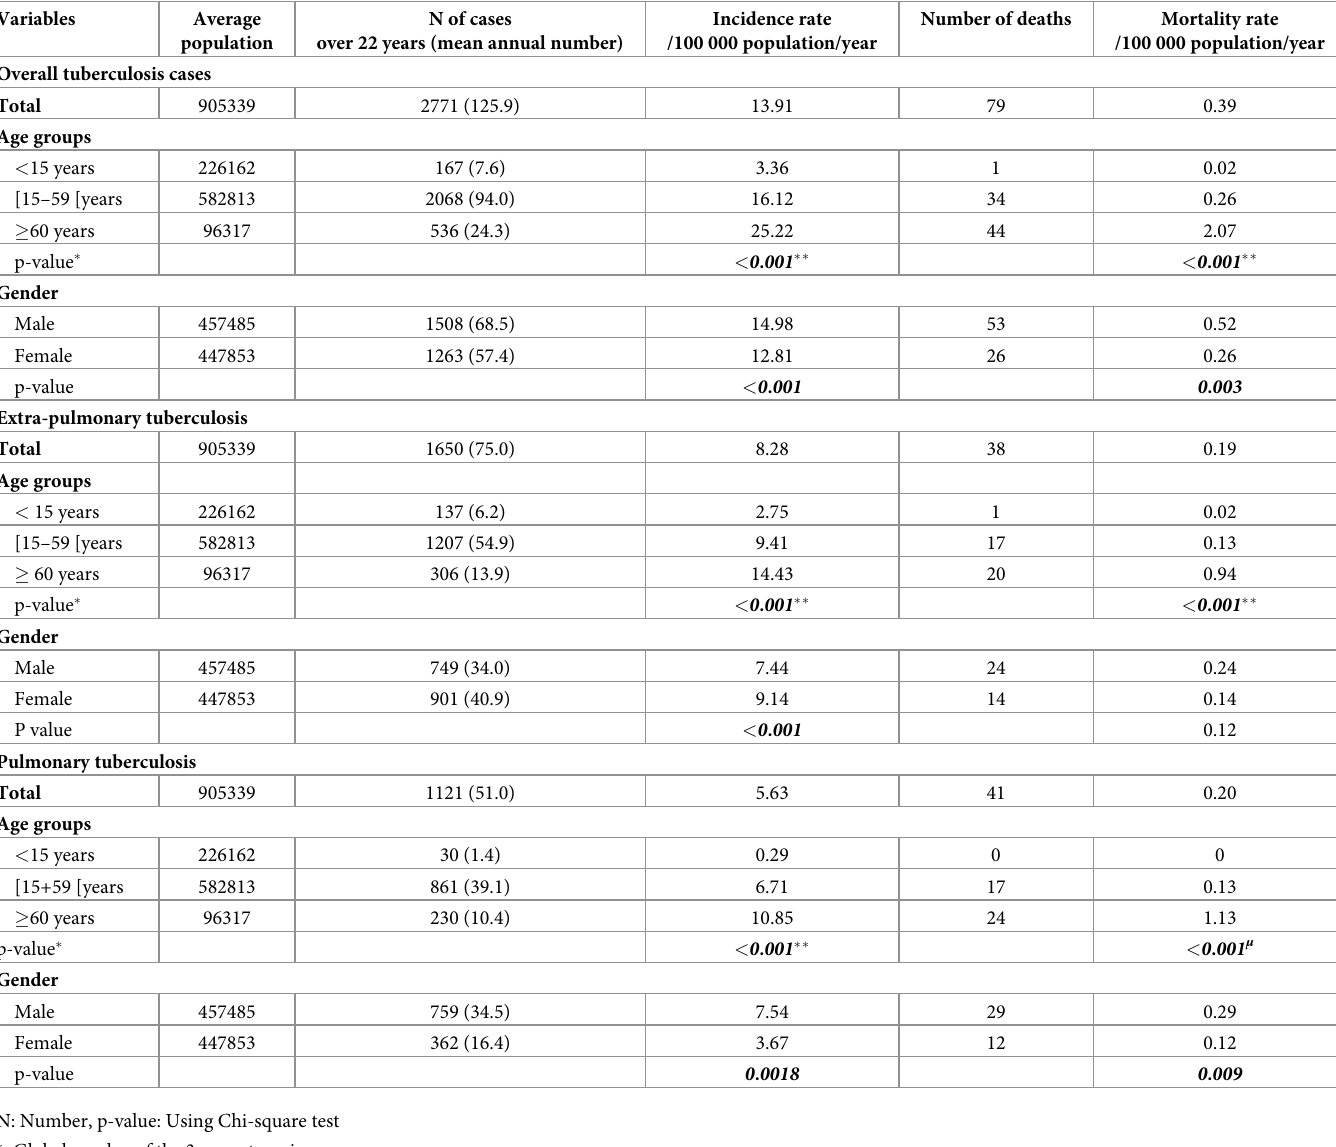
Table 2. Annual number of cases, incidence and mortality rates of pulmonary and extra-pulmonary tuberculosis stratified by gender and age groups.